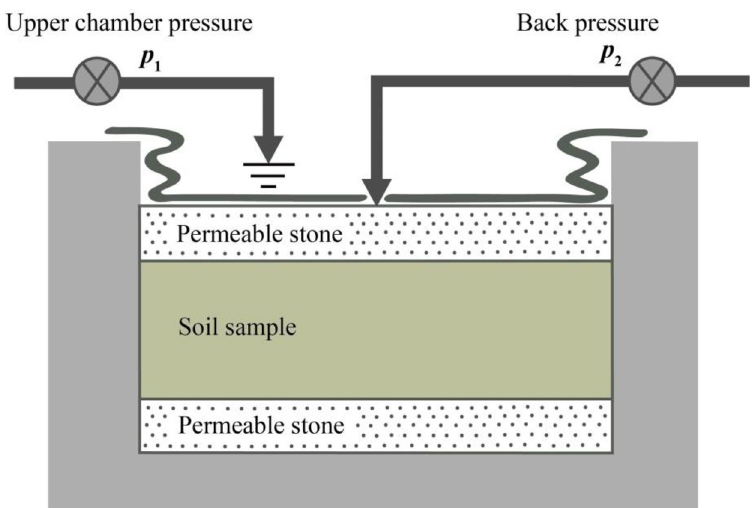
Fig 3. Schematic illustrating the upper chamber pressure p 1 and back pressure p 2 act on the soil samples.